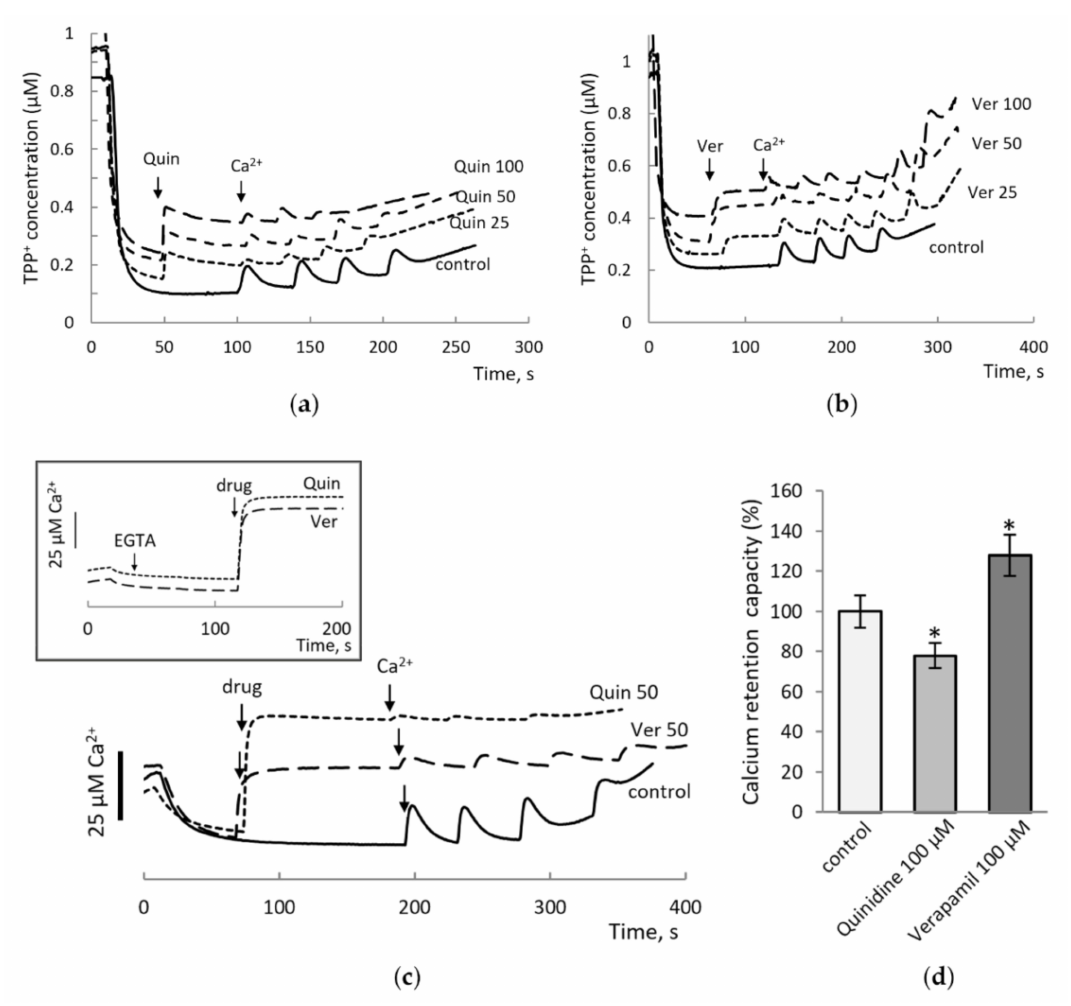
Figure 1. Influence of quinidine and verapamil on MPTP opening induced by calcium ions. MPTP opening in the course of successive additions of 25 µ M CaCl 2 determined by a drop of the membrane potential in the presence of quinidine (Quin) ( a ) and verapamil (Ver) ( b ) at a concentration of 25, 50, 100 µ M and by Ca 2+ release in the presence of 50 µ M quinidine and 50 µ M verapamil ( c ), no effect of EGTA on the rise of the curves caused by the addition of drugs (c, insert); a changes in the calcium retention capacity at the present of quinidine and verapamil ( d ). Asterisk (*) indicates values that differ significantly from the control values ( p <